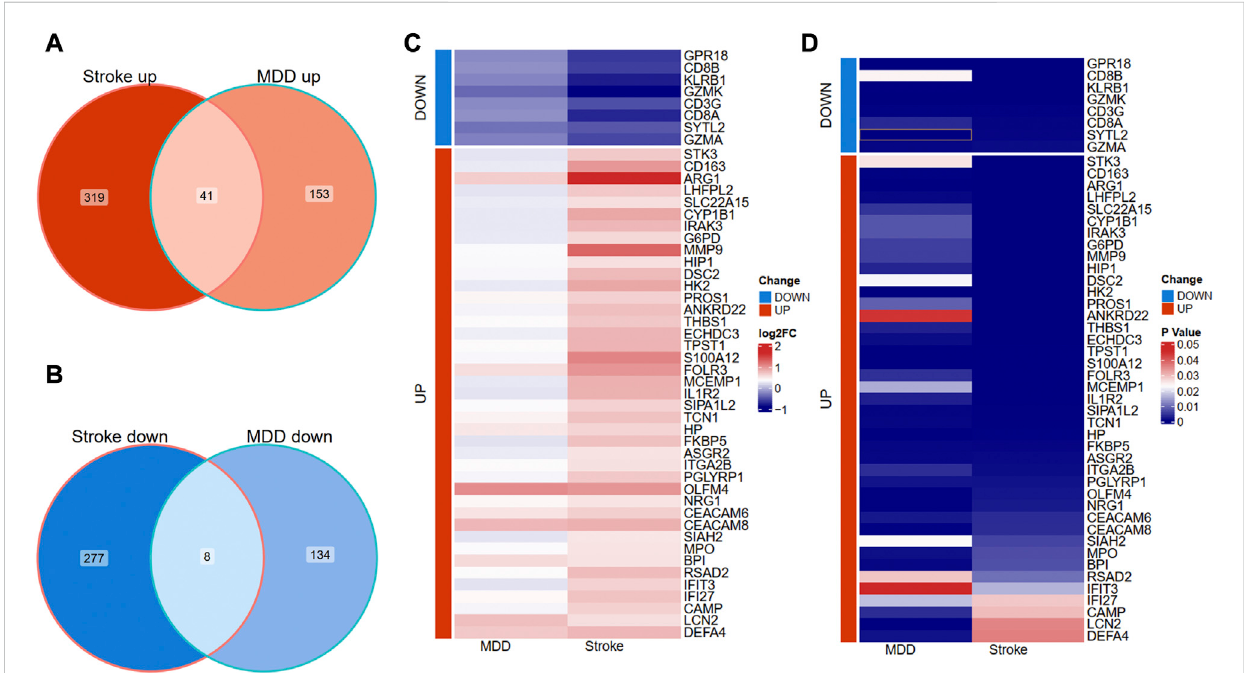
FIGURE 3 Identi fi cationofsharedDEGsbetweenMDDandIS. (A) OverlappingthesharedupregulatedDEGs. (B) OverlappingtheshareddownregulatedDEGs. (C) AheatmapindicatesthesharedDEGsfromtheperspectiveoflog(Foldchange). (D) AheatmapindicatesthesharedDEGsfromtheperspectiveofthe p -value. MDD, major depressive disorder; IS, ischemic